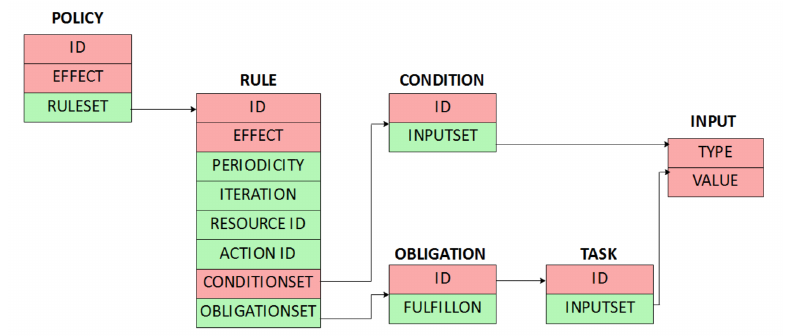
Figure 5. Hidra policy language